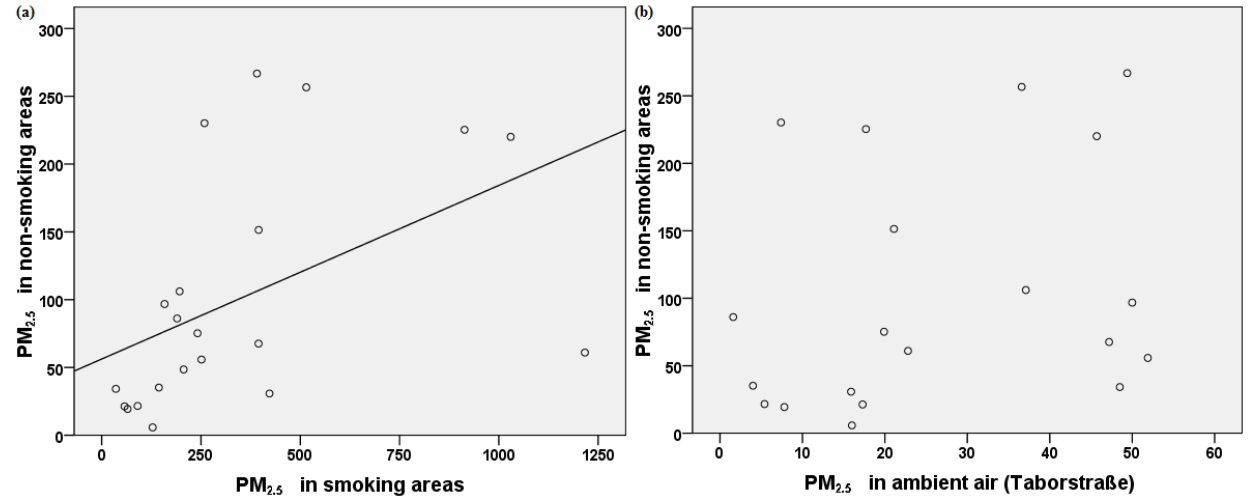
Figure 3. Two diagrams relating PM concentrations in ‟non-smoking areas‟ of mixed 2.5 type venues to ( a ) the PM concentrations in the adjacent smoking sectors and ( b ) to 2.5 PM at the next outdoor monitoring station. The regression line in ( a ) with a slope of 2.5 0.134 estimates the increase of PM in so-called „non-smoking areas‟ with neighboring 2.5 PM from tobacco smoke. 2.5